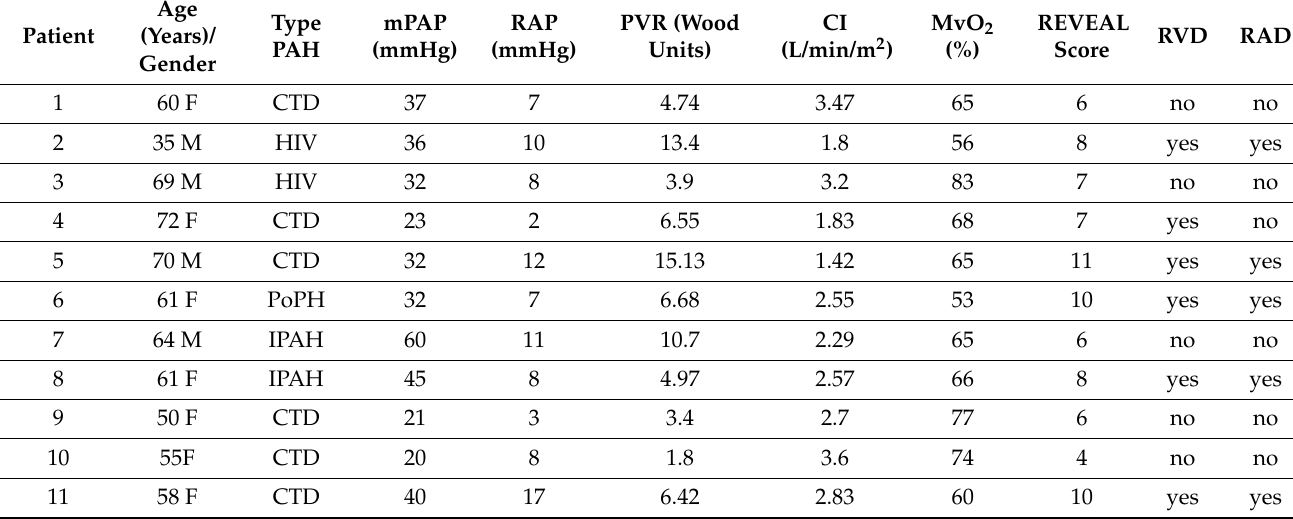
Table 1. Cause and severity of pulmonary arterial hypertension (PAH) at last assessment ( n = 11): right heart catheterization, REVEAL score, and